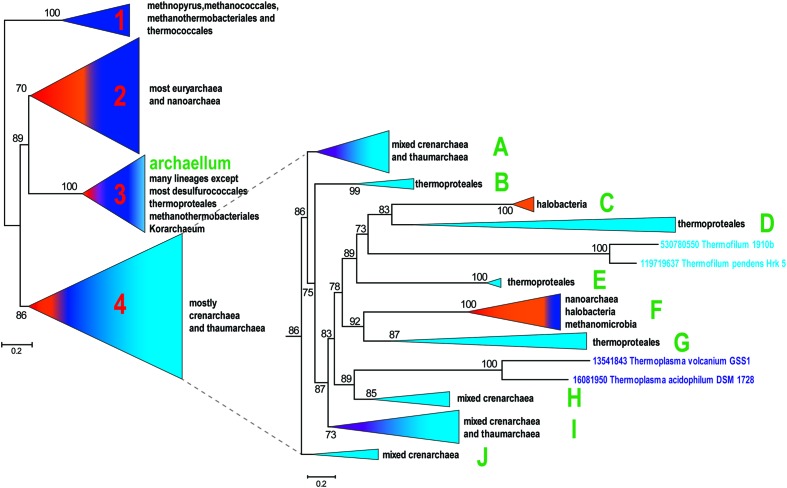
Schematic phylogenetic tree of archaeal secretion ATPases. The tree was reconstructed from a multiple alignment containing 356 sequences and 268 aligned positions. The bootstrap values are shown for clades with >70% support. All clades except 4 major ones are collapsed in the left panel and the topology of clade 4 is detailed in the right panel. The subclades of clade 4 that are discussed in the text are denoted A to J. Comment about the presence of major archaeal lineages is provided for each collapsed clade on the right side. Color code: Euryarchaeota, dark blue, with the exception of Halobacteria that are shown in orange; Crenarchaeota, light blue; Nanoarchaeota, red; Thaumarchaeota, Aigarchaeaota, and Korarchaeota, purple.